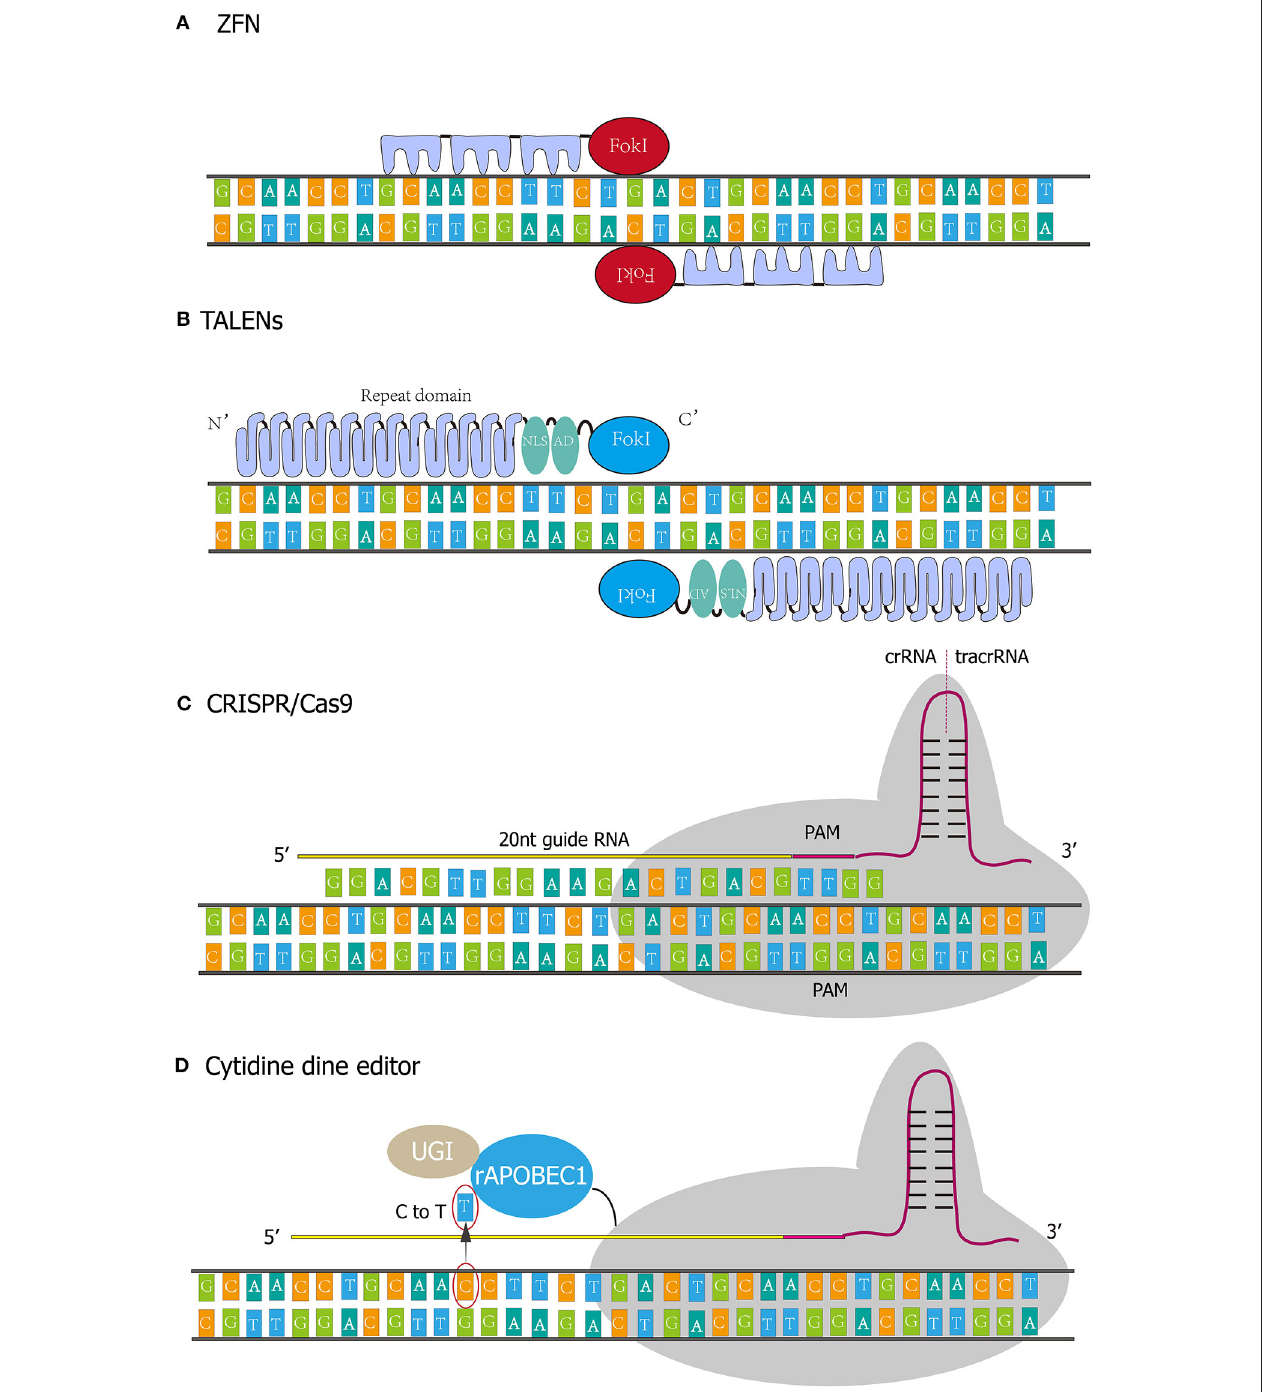
FIGURE 1 | Four kinds of gene-editing technologies. (A) The DNA binding domain of the Zinc finger generally contains three independent Zinc finger (ZF) repeats, and each ZF repeat recognizes three consecutive bases. (B) TALENs comprise translocation activation domain (AD), DNA binding domain, nuclear localization signals (NLS), and nuclease domain. Every repeat in DNA binding domain corresponds to nucleotides in a one-to-one relationship. (C) CRISPR/Cas9 system functions through protein nucleic acid complex. The whole system incorporates crRNA, tracrRNA, and Cas9 protein. crRNA contains single guide RNA (20 nt) and PAM sequence (NGG). (D) rAPOBEC1 is a cytidine deaminase that deaminates cytosine to uracil and then the uracil will be replaced by thymine. Uracil DNA glycosylase inhibitor (UGI) could elevate editing efficiency by inhibiting reversing the U-G pair to the original C-G pair.